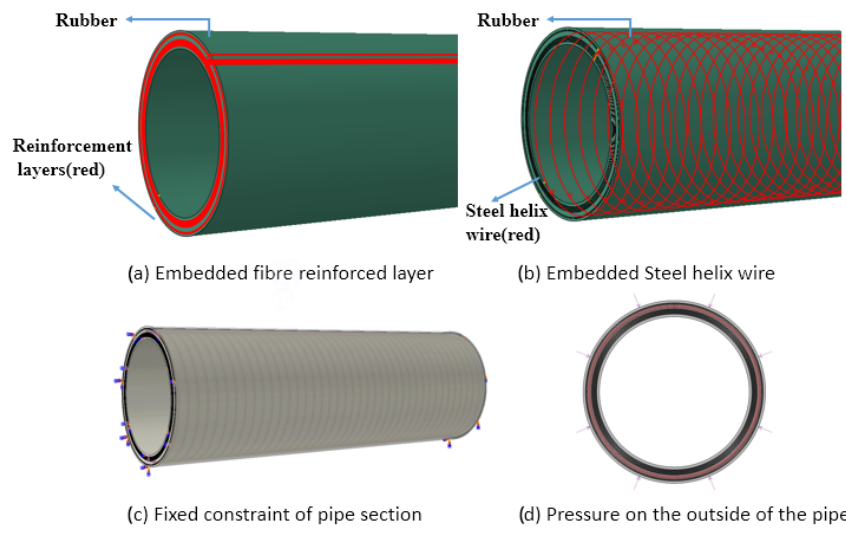
Figure 5. Interaction, loads and boundary conditions: ( a ) Embedded fibre reinforced layer, ( b ) em- bedded steel helix wire, ( c ) fixed constraint of pipe section, and ( d ) pressure on the outside of the pipe.